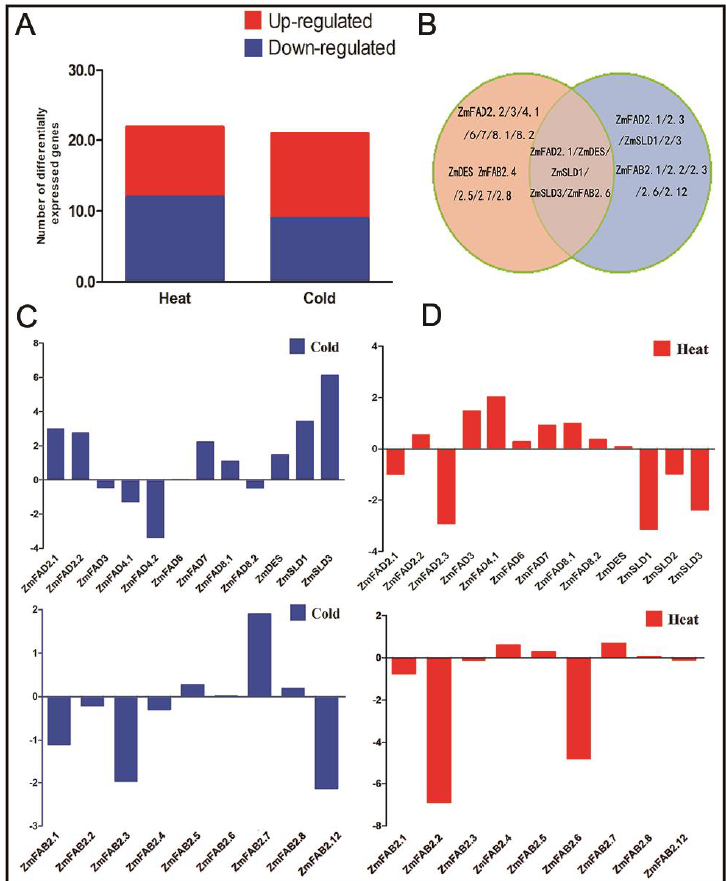
Figure 6. Expression profiles of the maize FAD and FAB2 genes under cold and heat stresses. ( A ) The number of up / down-regulated genes under cold and heat stresses; ( B ) Venn diagram describes the overlapping genes reacting on heat and cold stress; ( C ) expression of genes under cold stress; ( D ) expression of genes under heat stress.